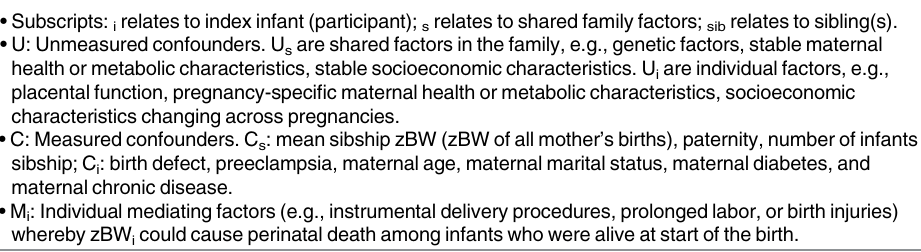
Fig 2. Causal diagram illustrating the relation between perinatal death and birth weight. zBW: z-score birth weight, standardized for year of birth, sex, birth order, gestational week, and